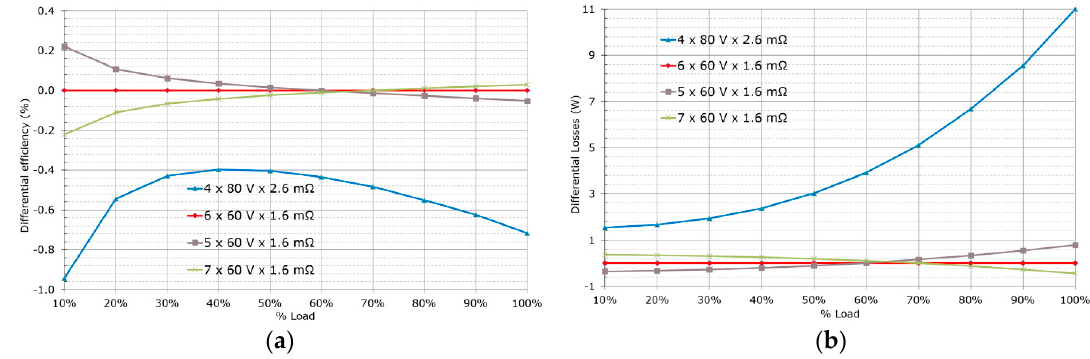
Figure 15. E ffi ciency for di ff erent LV MOSFETs voltage class and number of devices: ( a ) di ff erential Figure 15. Efficiency for different LV MOSFETs voltage class and number of devices: ( a ) differential e ffi ciencies; ( b ) di ff erential efficiencies; ( b ) differential losses.